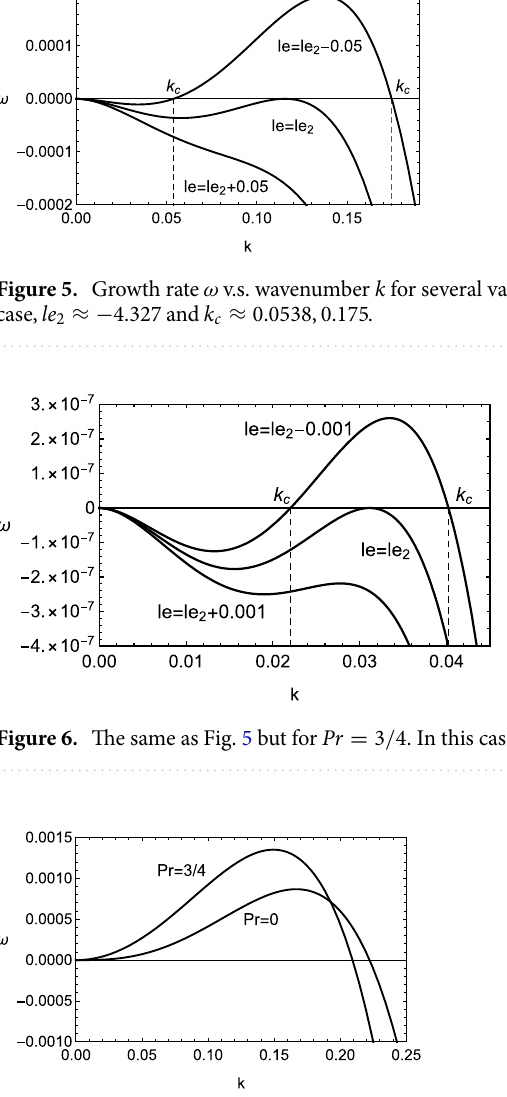
0 and 3/4, with β =